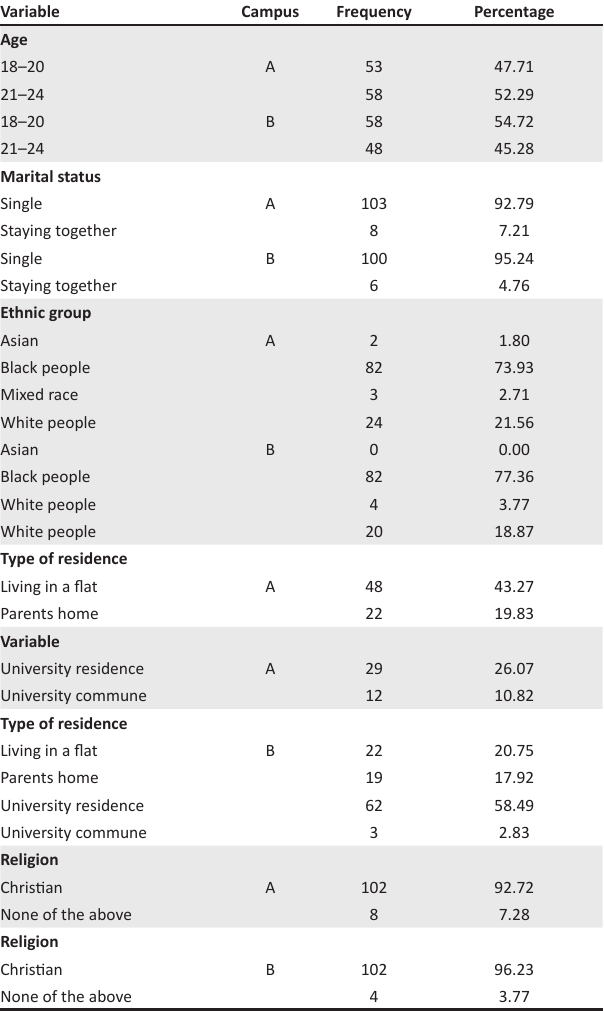
TABLE 3: Social and demographic characteristics of respondents ( n = 217). Variable